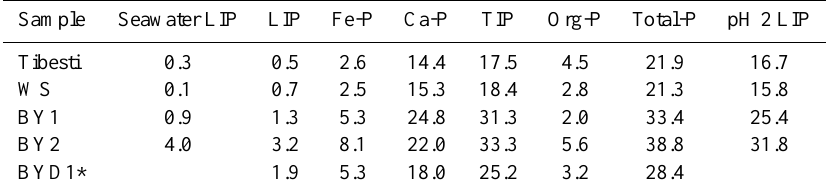
Table 1. Dust samples and simulated atmospheric processing results. All concentrations are given in µmol per gram dry weight. Sample